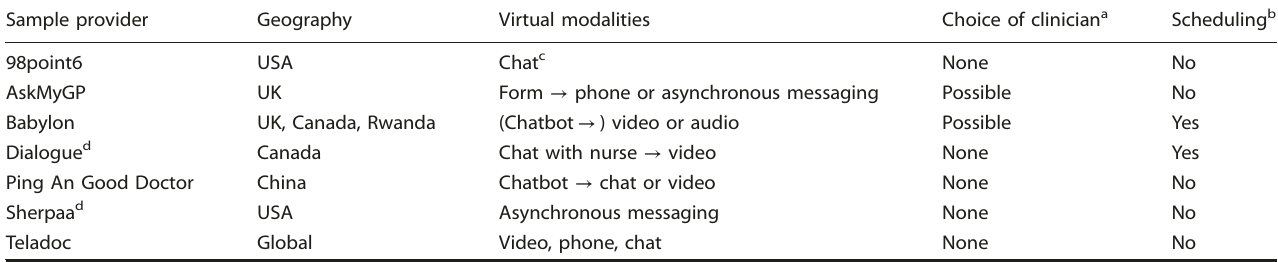
Table 1. Selected virtual primary care providers and their approaches (alphabetical